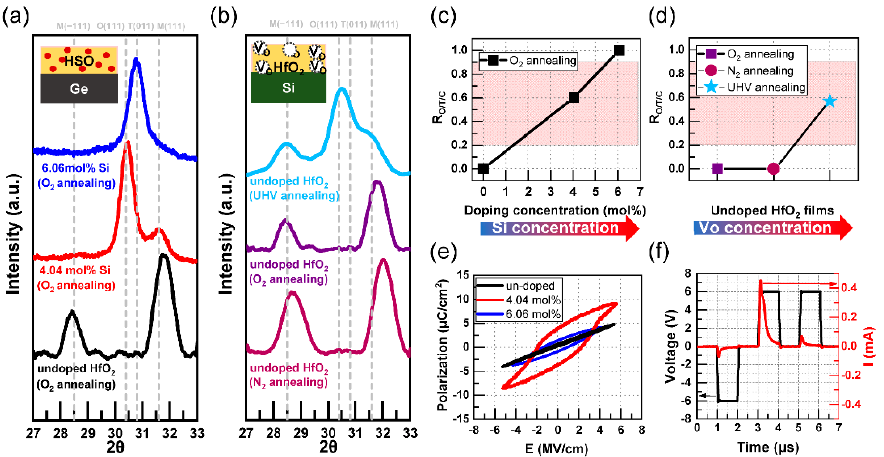
Figure 2. Summarized GIXRD patterns of ( a ) HSO films with different doping concentrations and ( b ) undoped HfO 2 films with different annealing atmospheres. ( c , d ) Extracted R O/T/C by fitting curves from ( a , b ). ( e ) PE curves of undoped, ~4% and ~6% HSO films with O 2 annealing. Only ~4% of doped HfO 2 films show ferroelectricity. ( f ) The difference in current measured by PUND measurement demonstrates that undoped HfO 2 films with UHV annealing are ferroelectric.